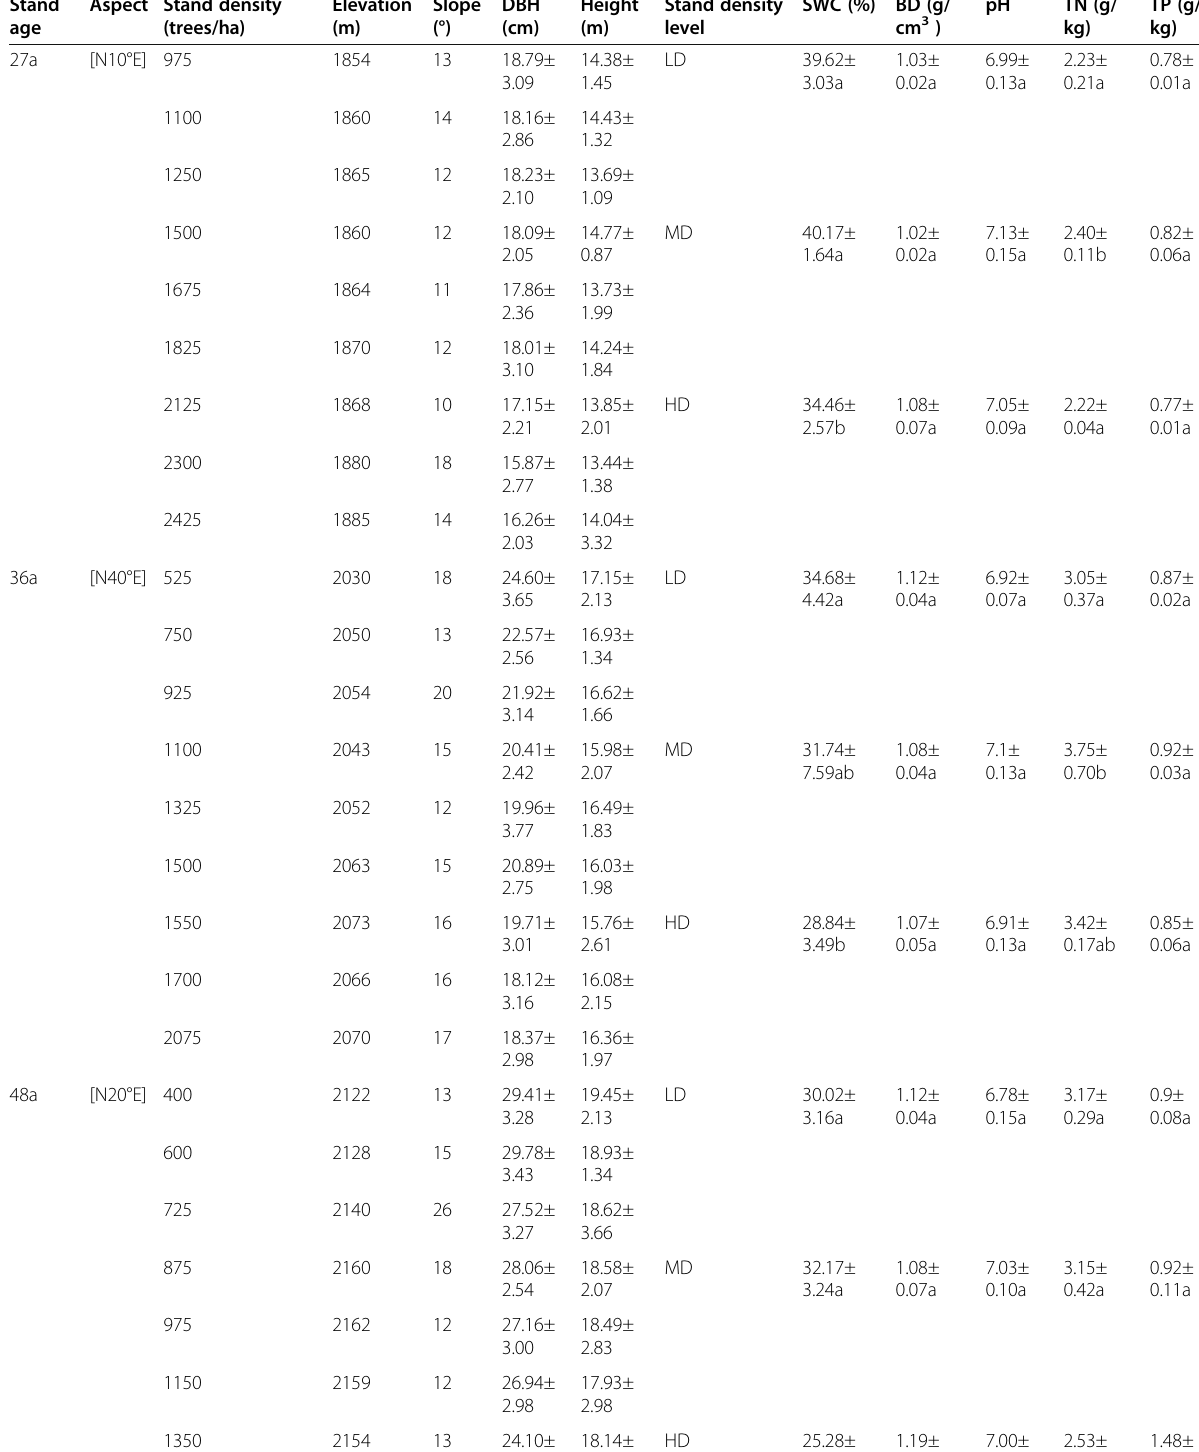
Table 1 Summary of the characteristics of the sample plots. [N40°E], [N10°E], and [N20°E] where N is the reference direction, and 40°E is the deviation from the reference direction heading east. SWC, soil moisture content; BD, soil bulk density; TN, soil total nitrogen content; TP, soil total phosphorus content; DBH, diameter at breast height; pH, hydrogen ion concentration. Values are the mean ± standard deviation (SD). Different lowercase letters (a, b, and c) indicate significant differences ( P < 0.05) between different stand density levels. 27a, 27-year-old stand; 36a, 36-year-old stand; 48a, 48-year-old stand Stand Aspect Stand density age